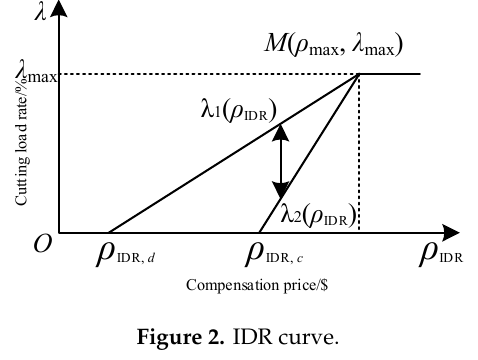
Figure 2. IDR curve.